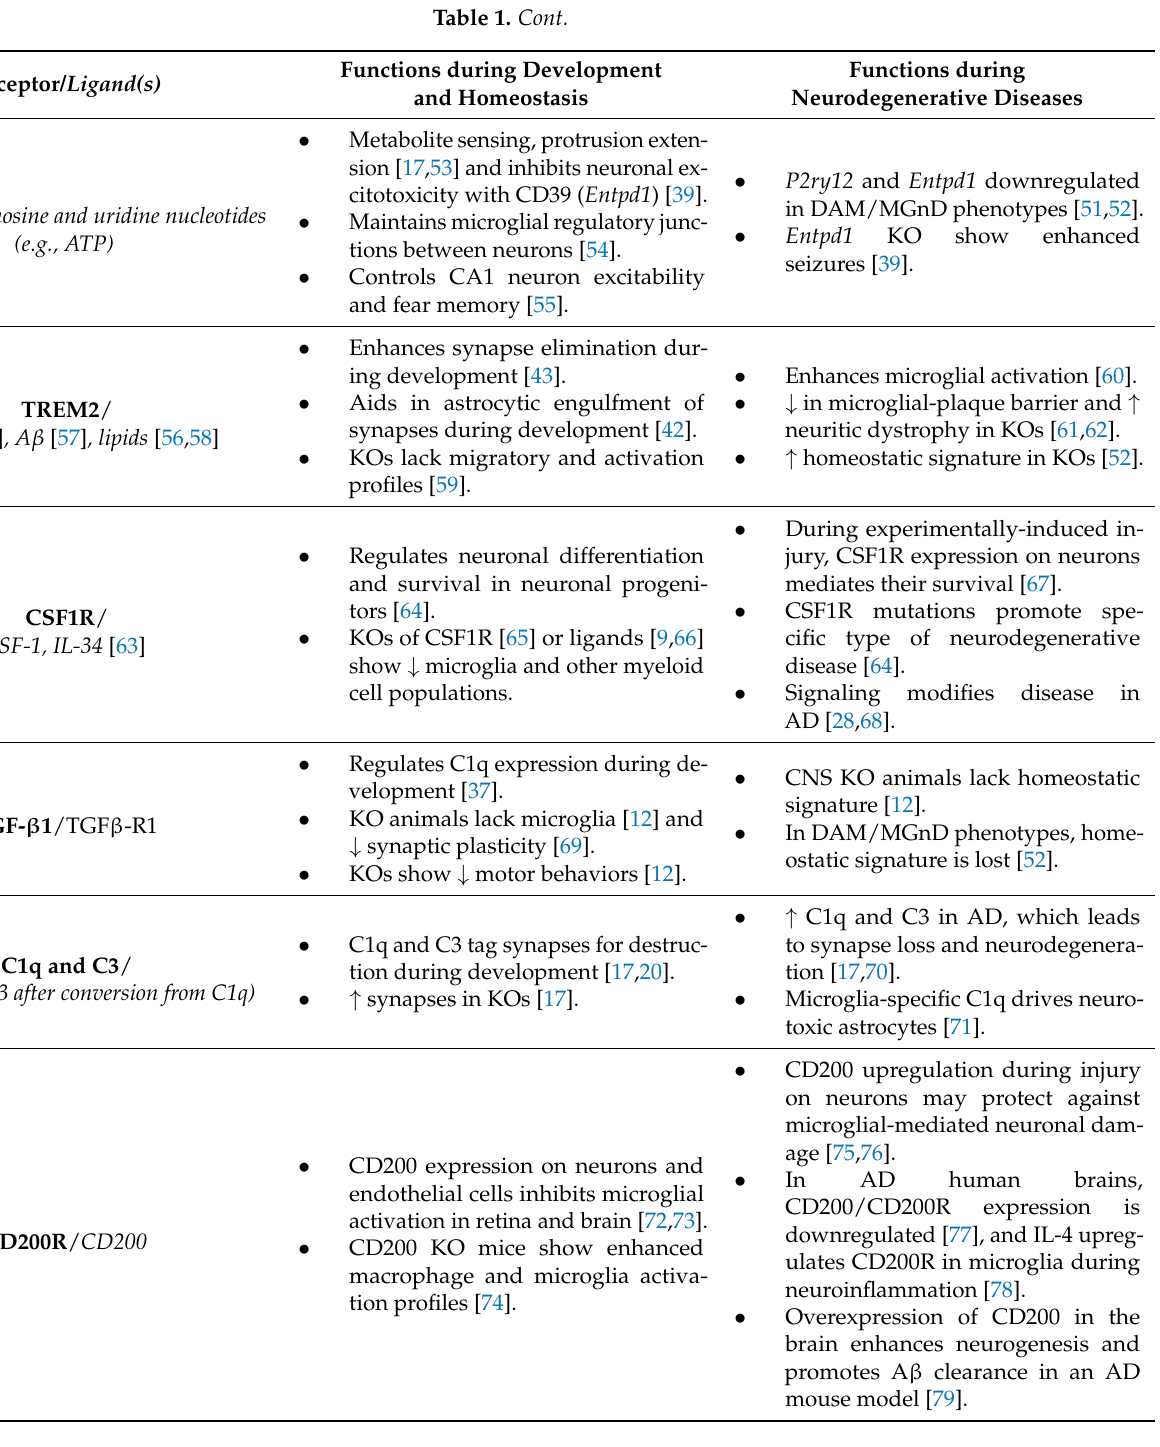
Table 1. Cont. Functions during Development and Homeostasis